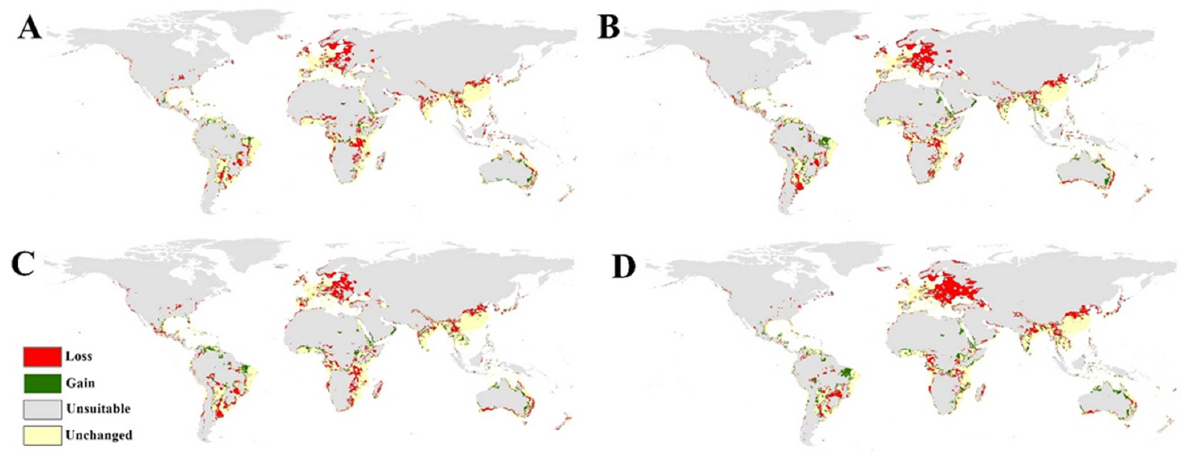
Figure 4. Calibration maps showing gain and loss in habitat suitability of A . niger through the four future scenarios against the current status with threshold (>0.5): ( A ) 2050 for RCP 2.6; ( B ) 2050 for RCP 8.5; ( C ) 2070 for RCP 2.6, and ( D ) 2070 for RCP 8.5.